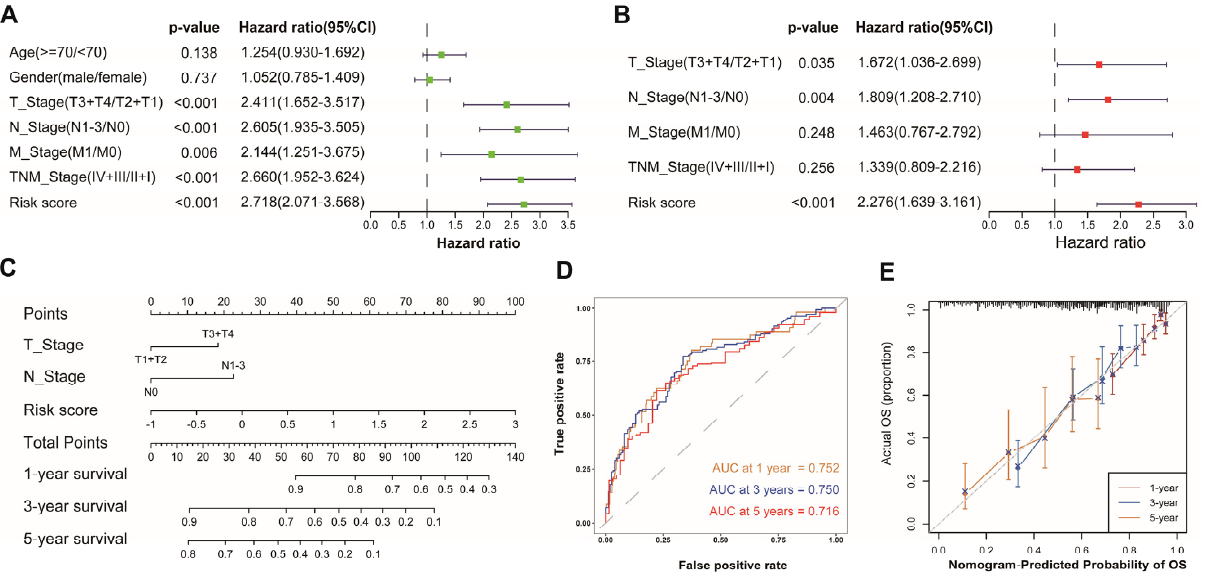
Figure 4. Validation of AAMRGS in GEO datasets. Kaplan-Meier survival analysis in GSE72094 ( A ) and GSE31210 ( B ). The distribution of risk scores and survival status in GSE72094 ( C ) and GSE31210 ( E ). Heatmap displaying six AAM-related genes in GSE72094 ( D ) and GSE31210 ( F ). Time-dependent ROC analysis in GSE72094 ( G) and GSE31210 ( H ).